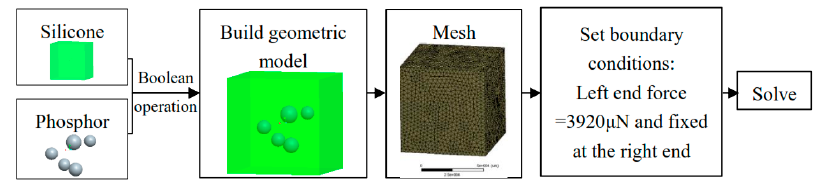
Figure 10. FEA modeling and simulation process.